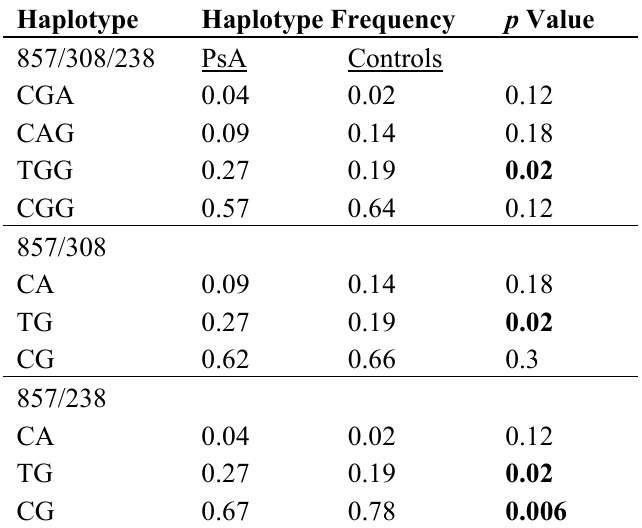
Table 3. TNF-alpha haplotypes in PsA patients and